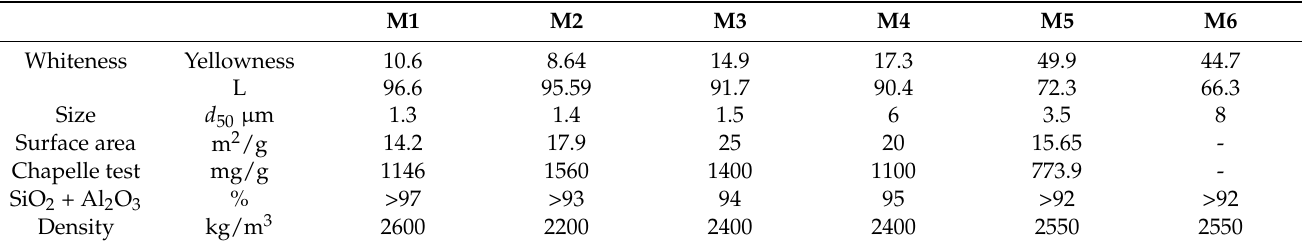
Table 5. Composition, physical properties and reactivity of the different types of metakaolin used. Data extracted from various product data sheets.